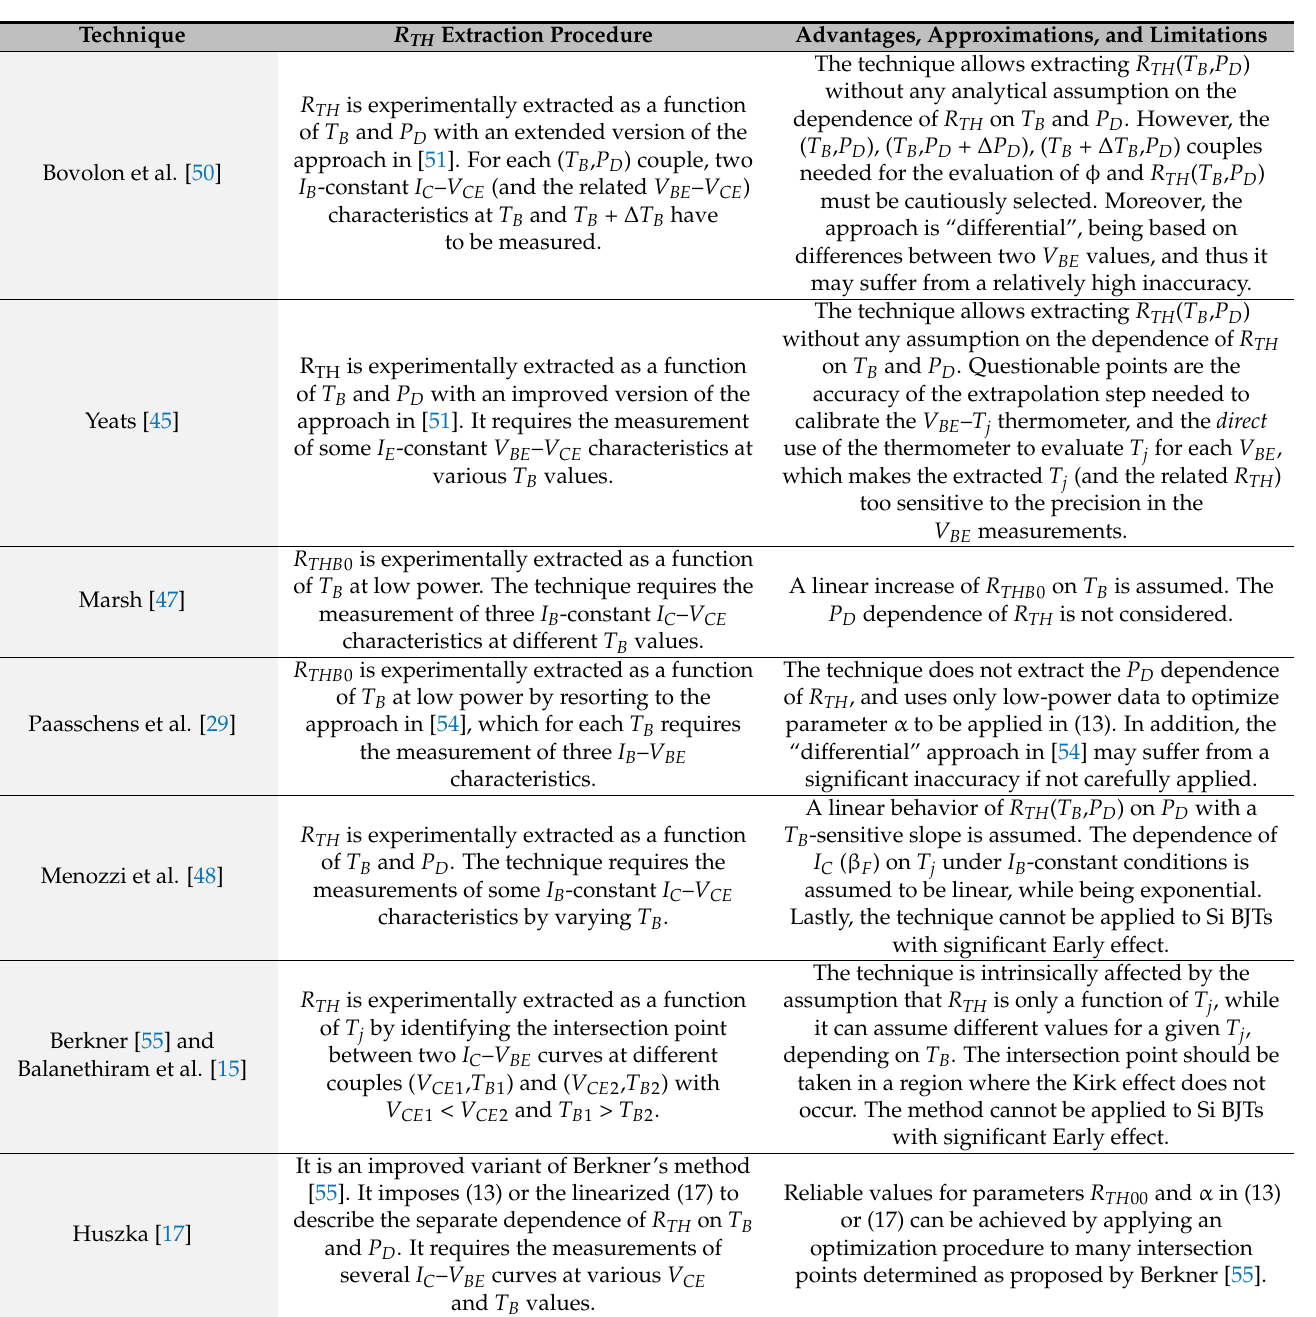
Table 2. Main features of the experimental R TH extraction techniques explicitly accounting for nonlinear thermal